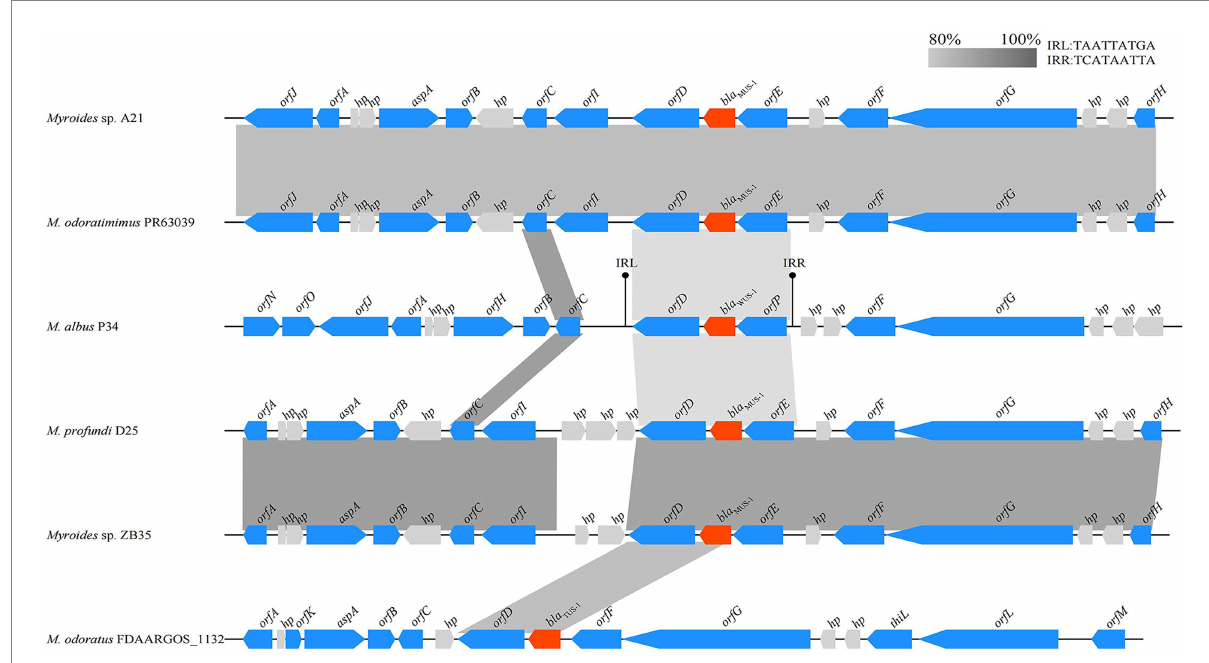
FIGURE 4 Comparison of the genetic environment of the blaWUS-1 gene with those sequences carrying its homologous genes. Genes are shown as arrows and colored based on gene function classification. Genes without functional annotation are colored in gray. Shading denotes homologous regions between them. The accession numbers are as follows: Myroides sp. A21 chromosome (CP010327.1), Myroides odoratimimus PR63039 chromosome (NZ_CP013690.1), M. profundi D25 chromosome (NZ_CP010817.1), Myroides sp. ZB35 chromosome (NZ_CP017769.1) and M. odoratus FDAARGOS_1132 chromosome (CP068107.1).